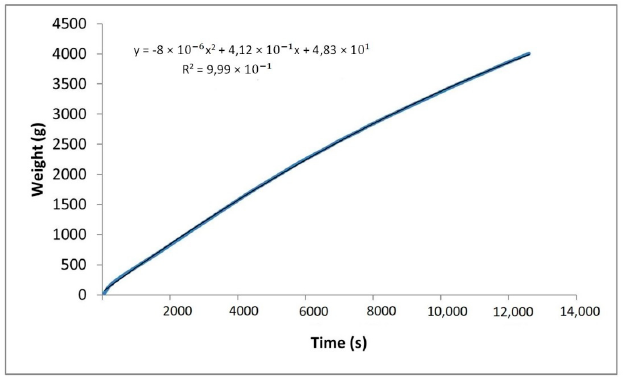
Figure 6. Water flow through untreated OSB.